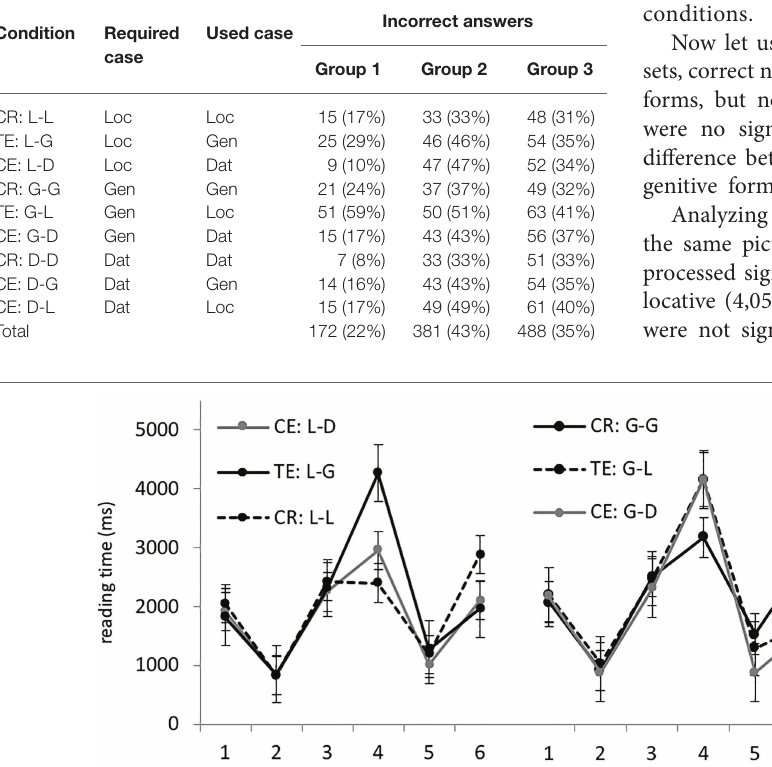
TABLE 4 | Incorrect answers in different